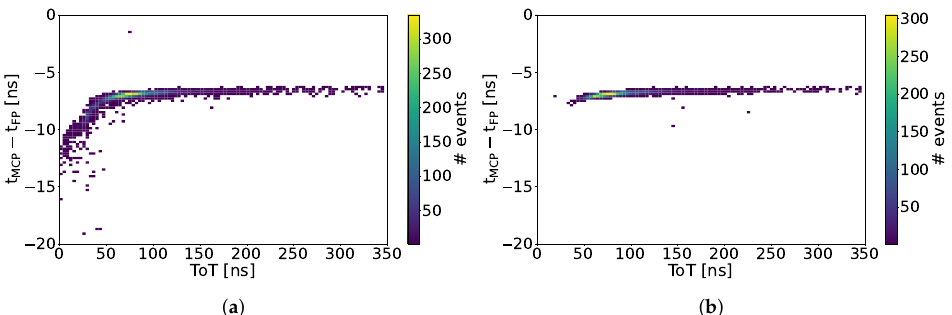
Figure 12. Seed-pixel time residuals as function of ToT for a single pixel on the edge of the 20µm pitch matrix ( a ) and in the inner region ( b ).